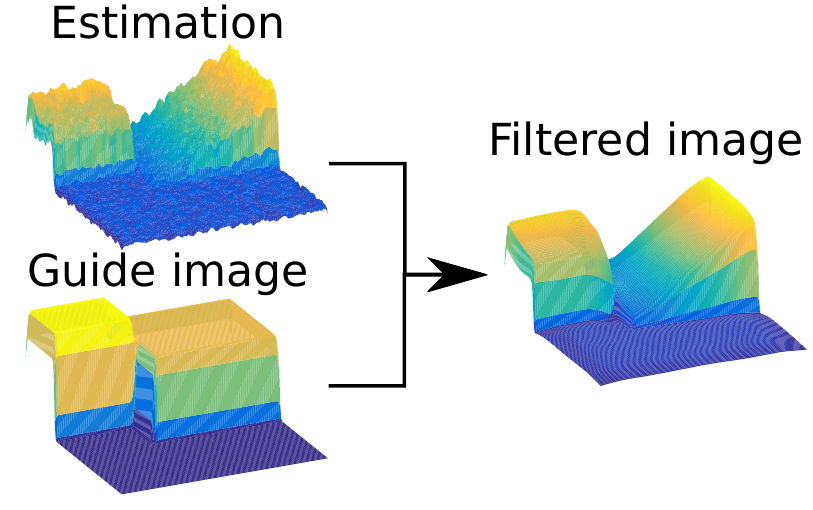
Figure 2. Guided filter